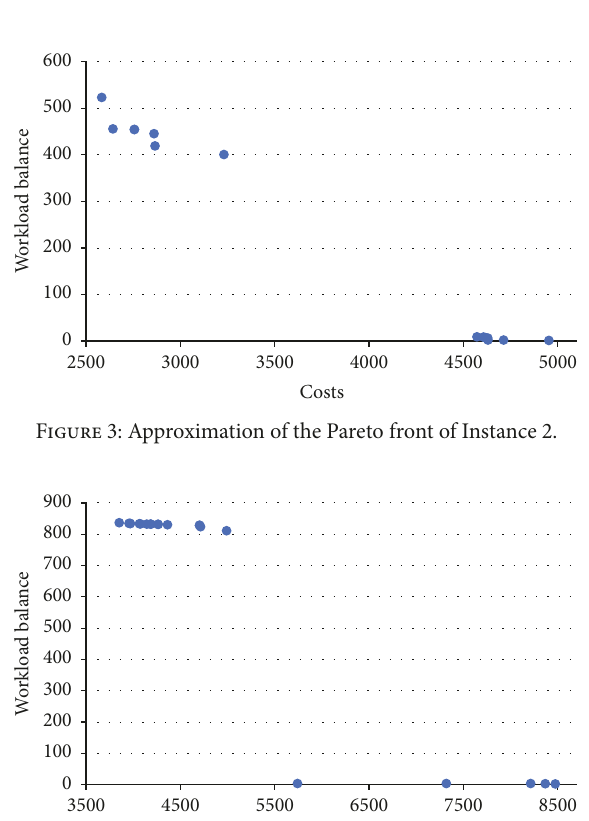
Figure 5: Approximation of the Pareto front of Instance 4.